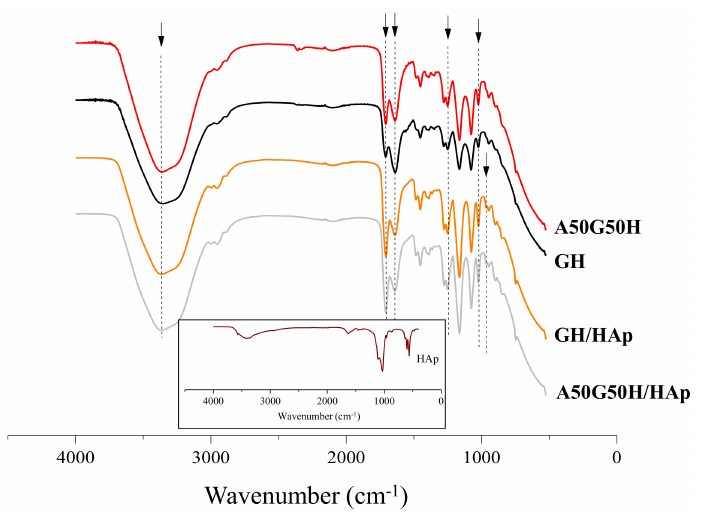
Figure 1. Fourier transform infrared spectroscopy (FTIR) spectra of hydrogel scaffolds (insert is FTIR spectrum of